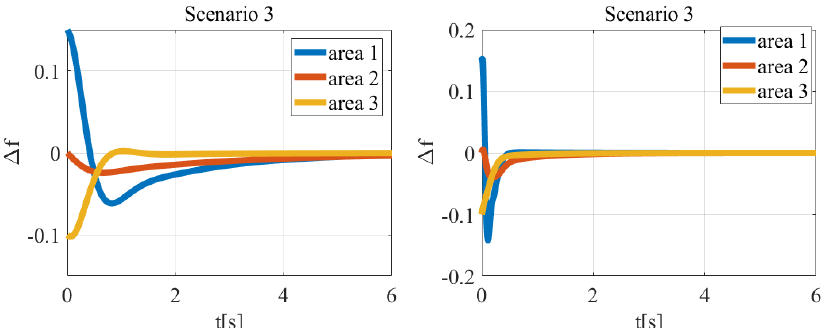
Figure 14. The time responses of ∆ f with LQR ( left figure) and fuzzy controller ( right figure) controller for different areas—scenario